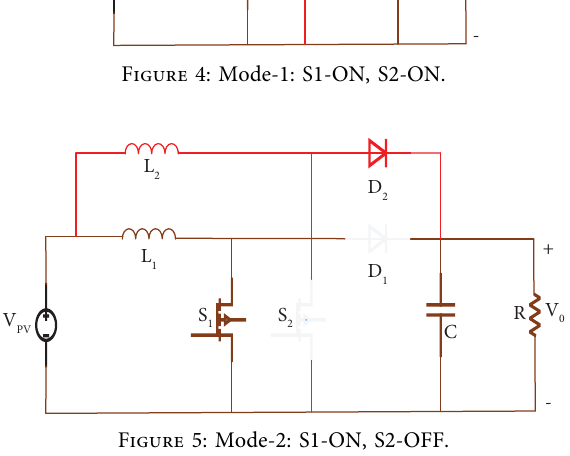
Figure 4: Mode-1: S1-ON, S2-ON.